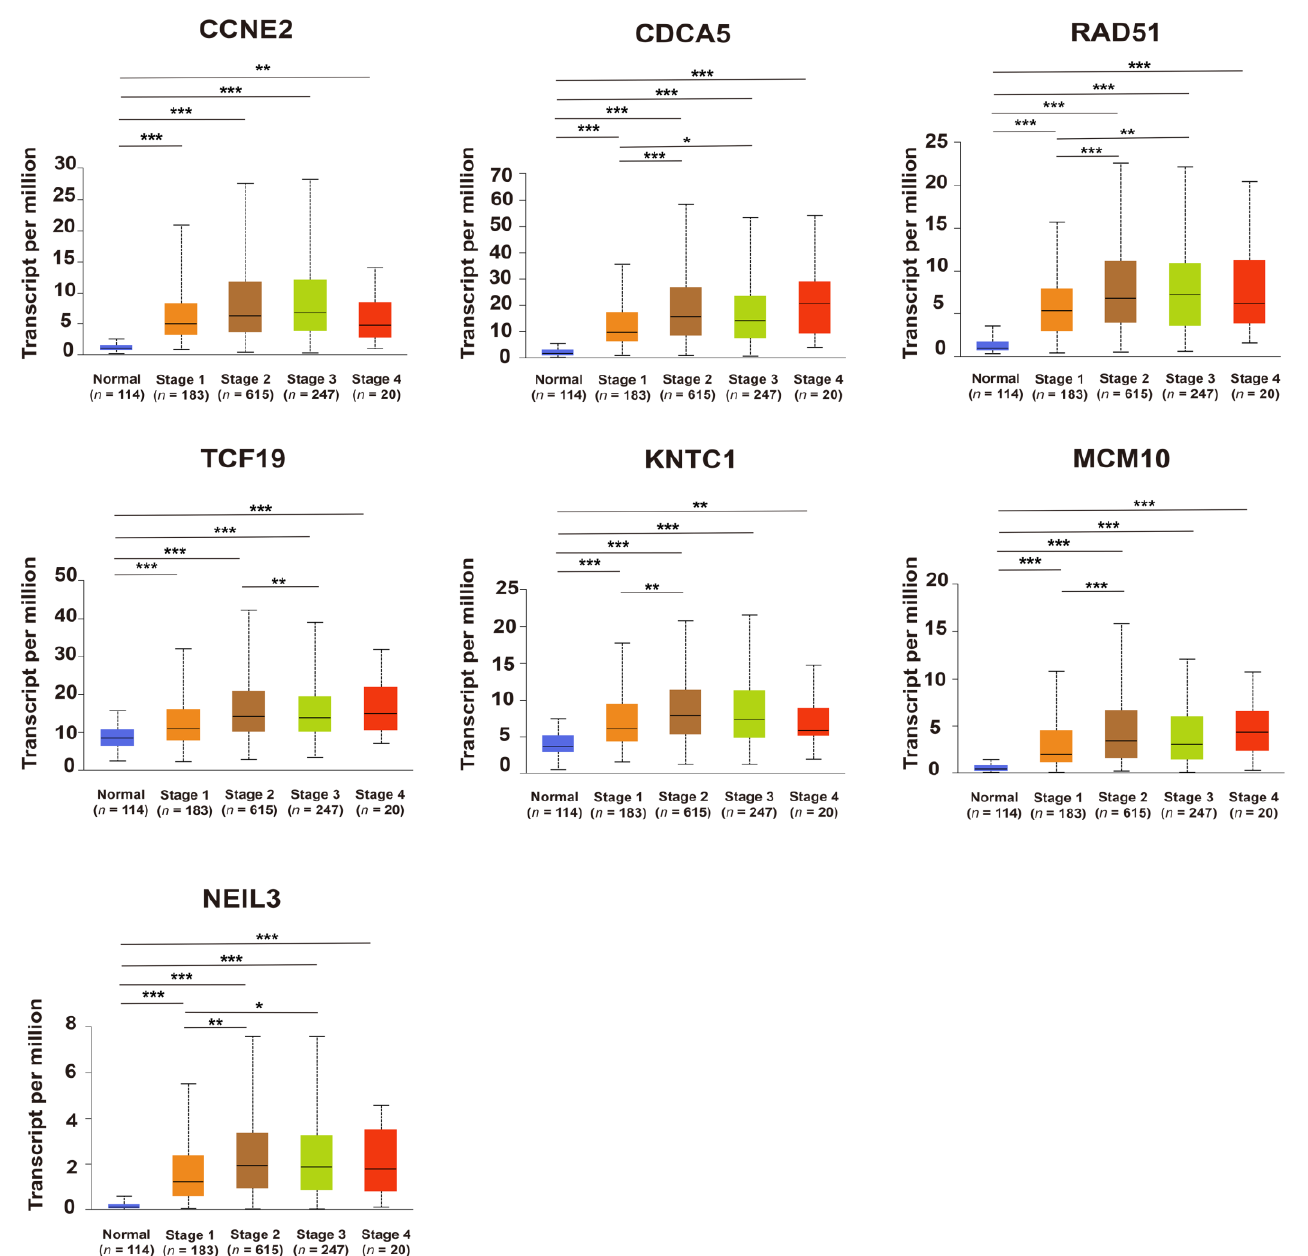
Figure 5. The expression of candidate genes ( CCNE2, CDCA5, RAD51, TCF19, KNTC1, MCM10, and NEIL3 ) in different breast cancer stages according to the UALCAN database. * p < 0.05, ** p < 0.01, and *** p < 0.001.